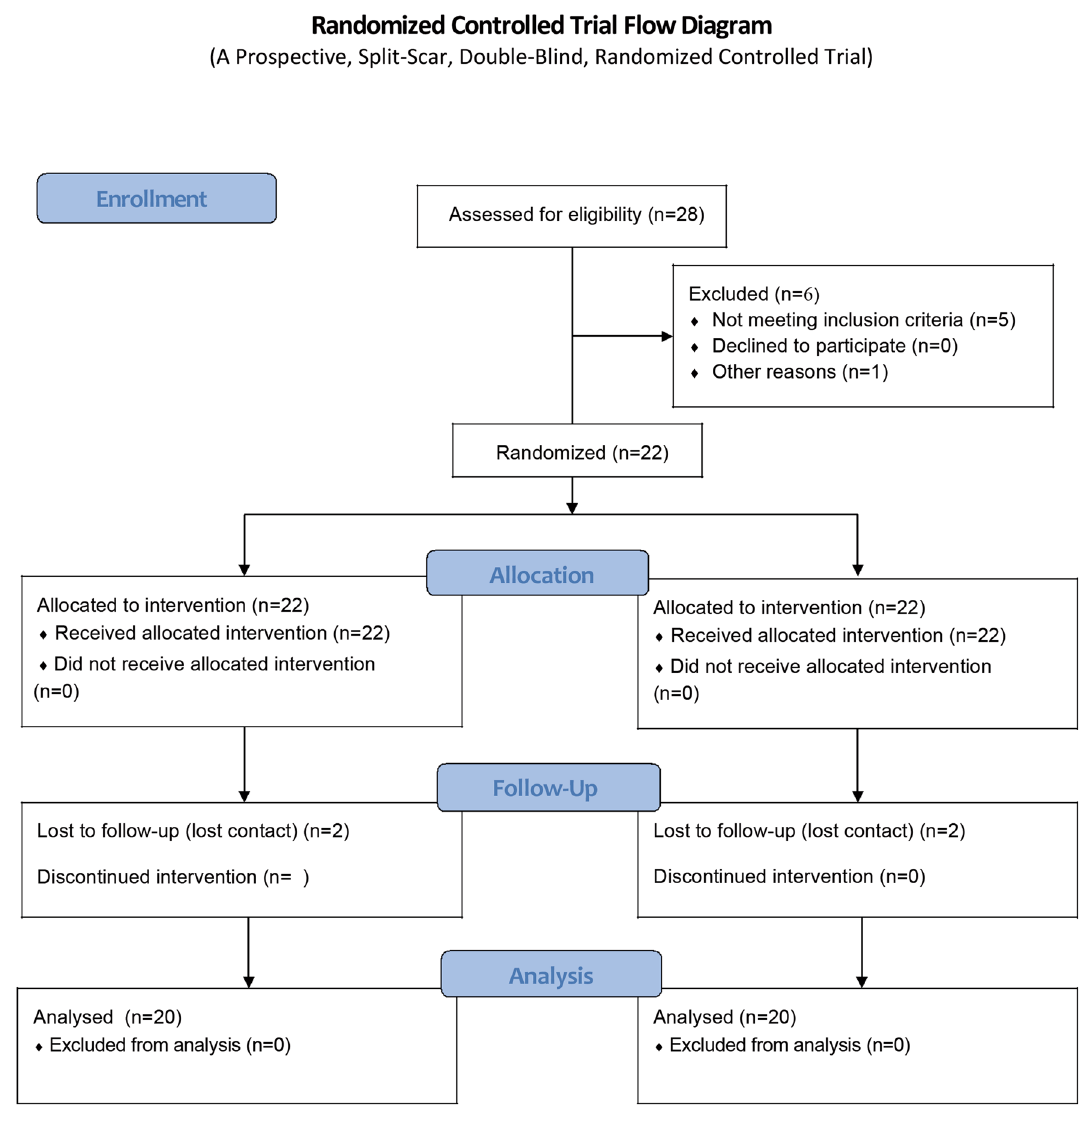
Figure 1. Randomized controlled trial flow